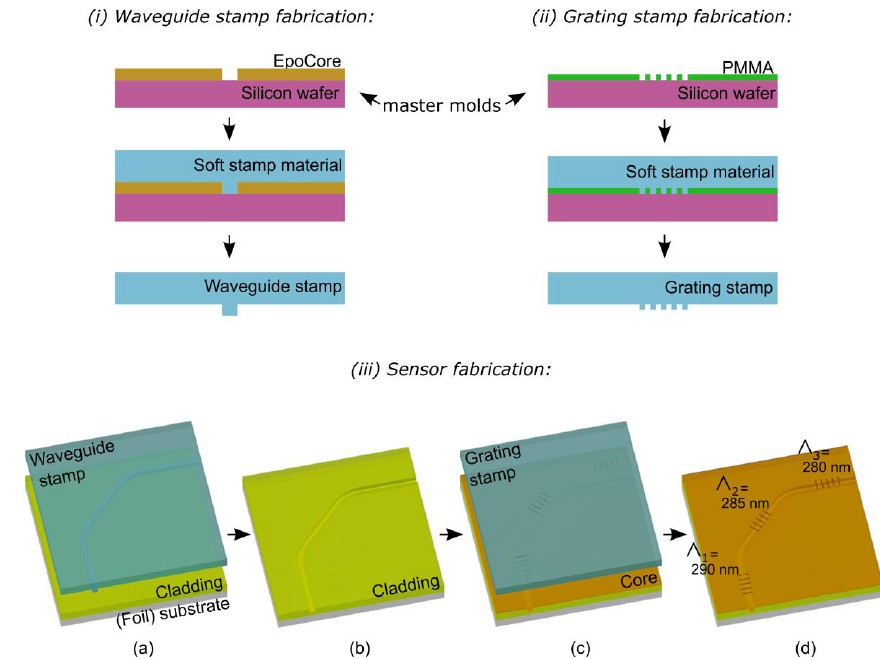
Figure 3. Process flow for the imprinting of waveguides with grating sensors.